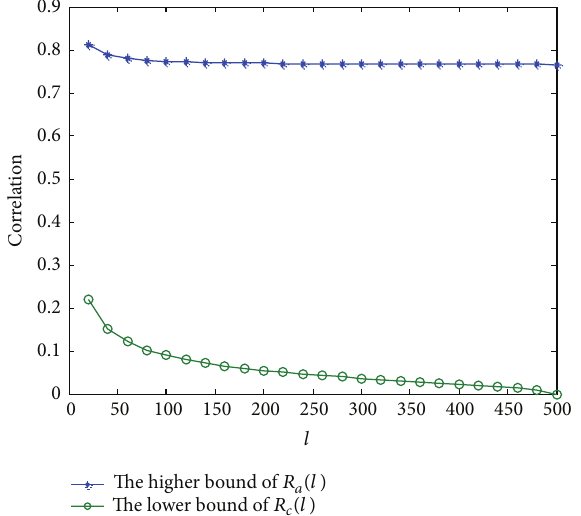
Figure 2: The higher bound of 𝑅 𝑎 (𝑙) and the lower bound of 𝑅 𝑐 (𝑙)